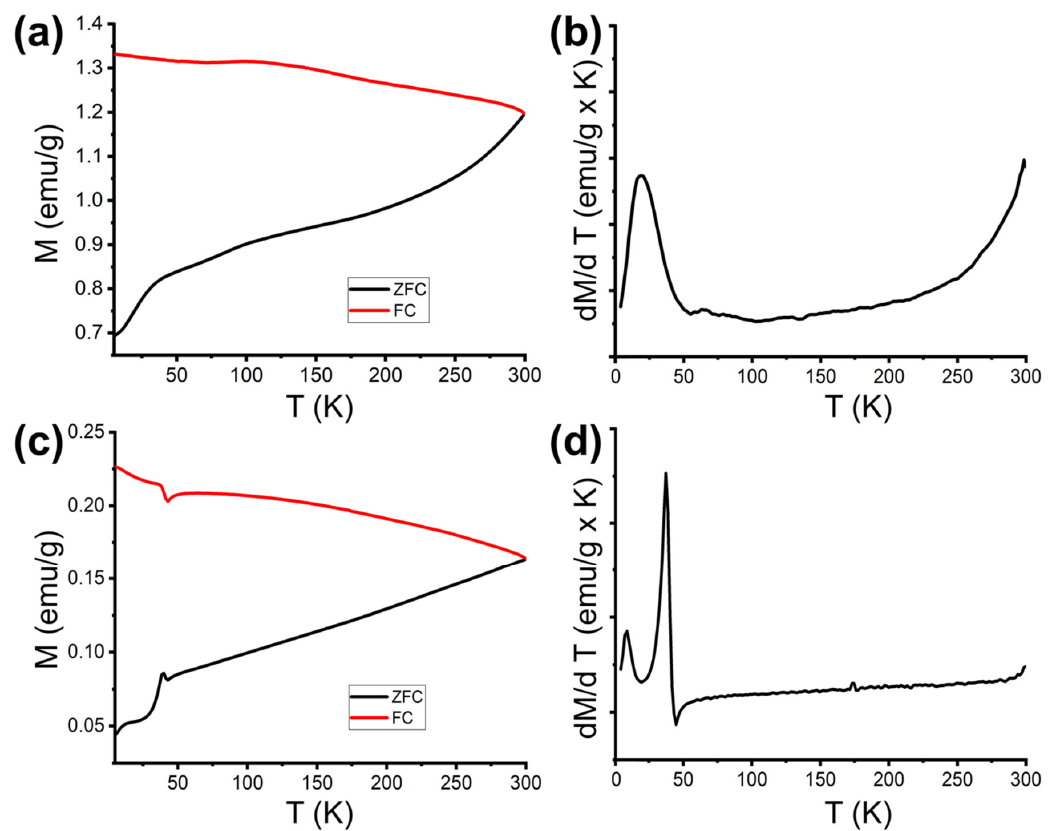
Figure 4. Zero-field-cooled / field-cooled (ZFC-FC) magnetization curves and their derivative of samples S3 and S3_Mn: ( a ) ZFC-FC curves of S3, ( b ) derivative curve (d(M ZFC –M FC ) / dT vs. T) of sample S3, ( c ) ZFC-FC curves of sample S3_Mn; ( d ) derivative curve (d(M ZFC –M FC ) / dT vs. T) of sample S3_Mn.